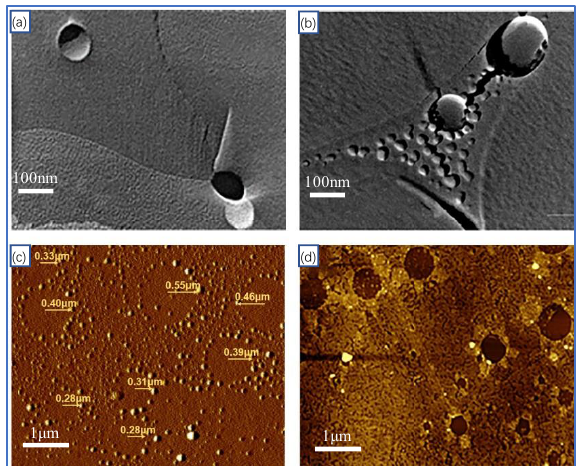
Figure 1. Transmission electron microscope image of MNBs in different hydrate dissociation solution: ( a ) Methane MNBs from freeze-fractured samples of hydrate dissociation solution [42], ( b ) Nitrogen MNB generation by freezing separation in frozen liquid nitrogen [43], ( c ) THF solution generates MNBs of various sizes at room temperature [44], ( d ) generating multiple sizes of MNBs in 0.01 M concentration NaCl solution [45].